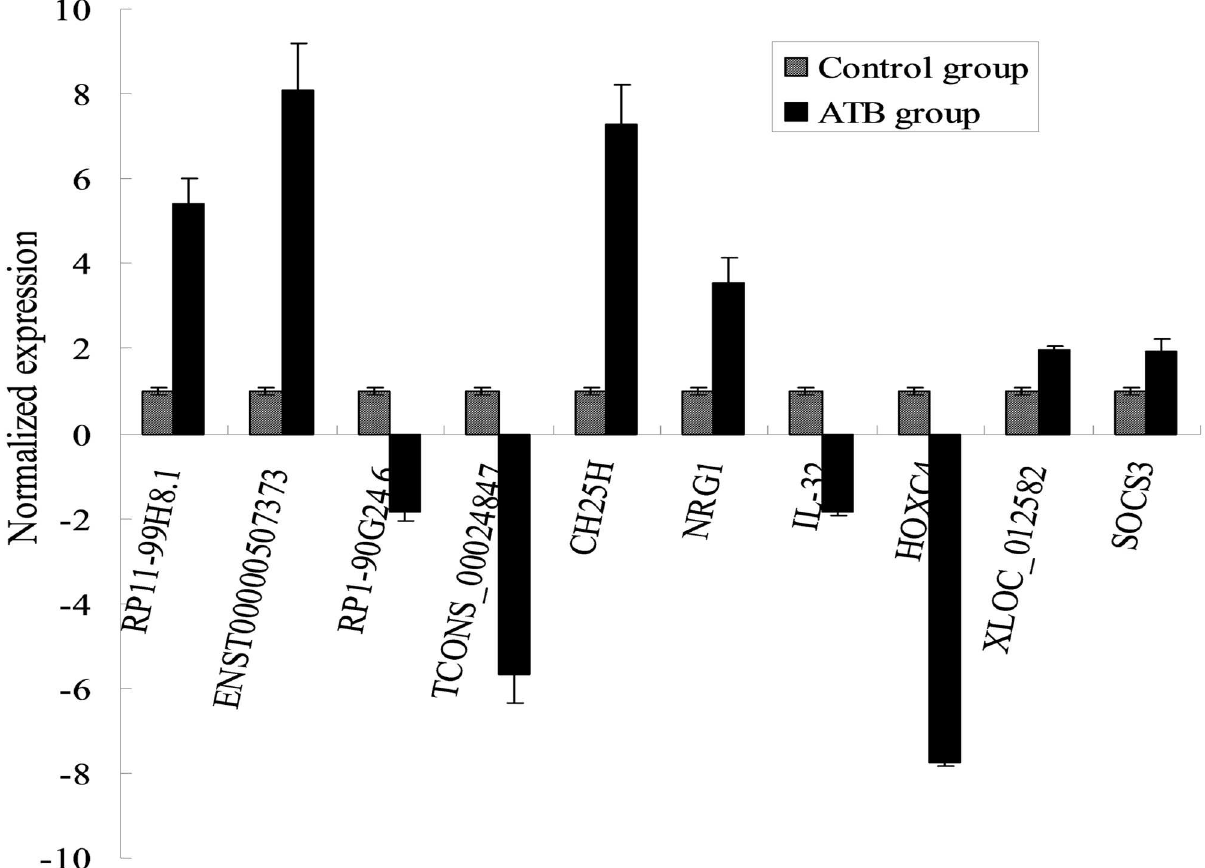
Fig 3. RT-qPCR validation results of the randomly selectedlncRNAs and mRNAsbetween ATB group and control group. Four lncRNAs RP11-99H8.1, ENST00000507373,RP1-90G24.6, TCONS_00024847 and four mRNAs CH25H, NRG1, IL-32, HOXC4 were chosen for the validationof the microarray data usingRT- qPCR. The height of the columns in the figure representsthe lncRNA expression level relative to GAPDH; the bars represent SD. * P < 0.05 versus control group.